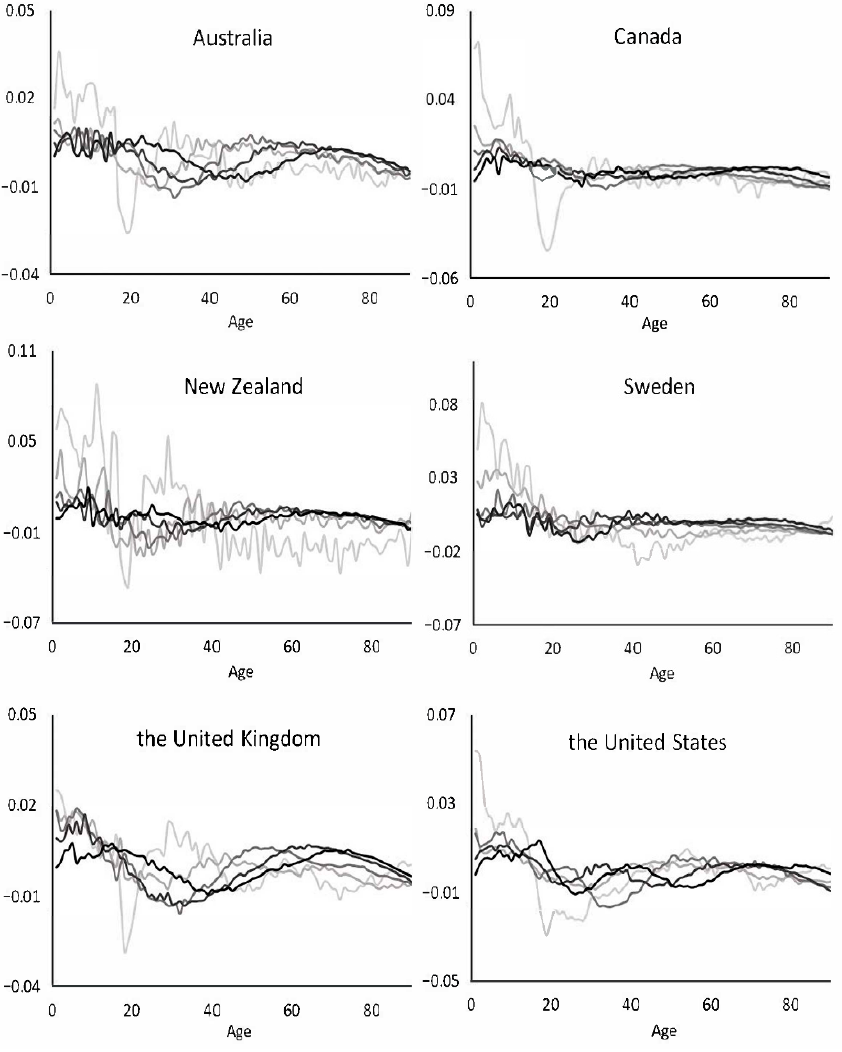
Figure 1. Age sensitivity factors under the Lee-Carter model estimated from sequential subsamples with a fixed sample size.